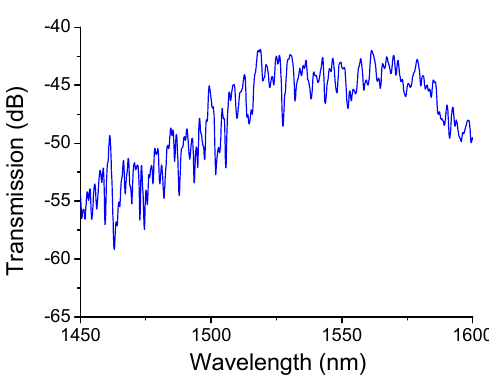
Figure 13. Schematic of singlemode-periodically tapered PCF-singlemode fiber structure.